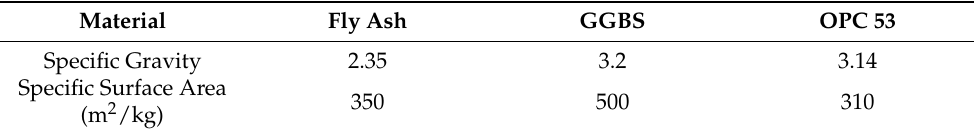
Table 2. Physical properties of mineral admixtures.